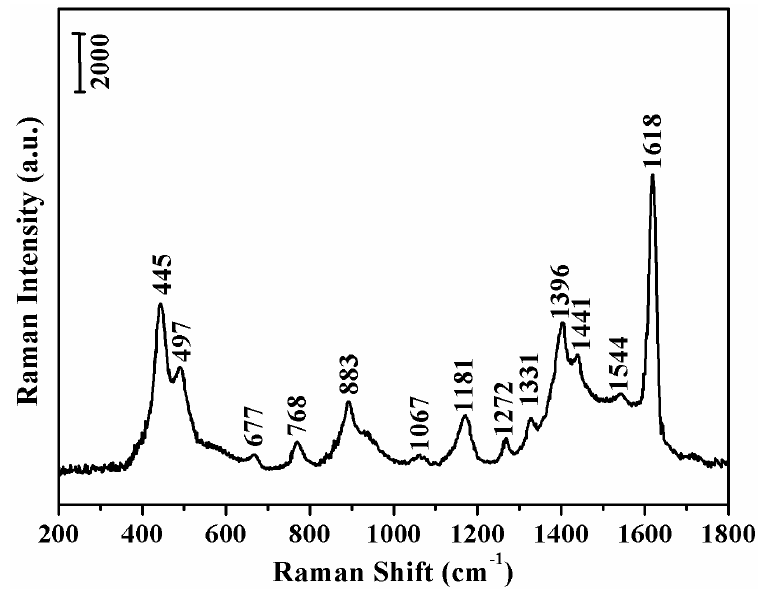
Figure 4. Raman spectrum of MB in ethanol.